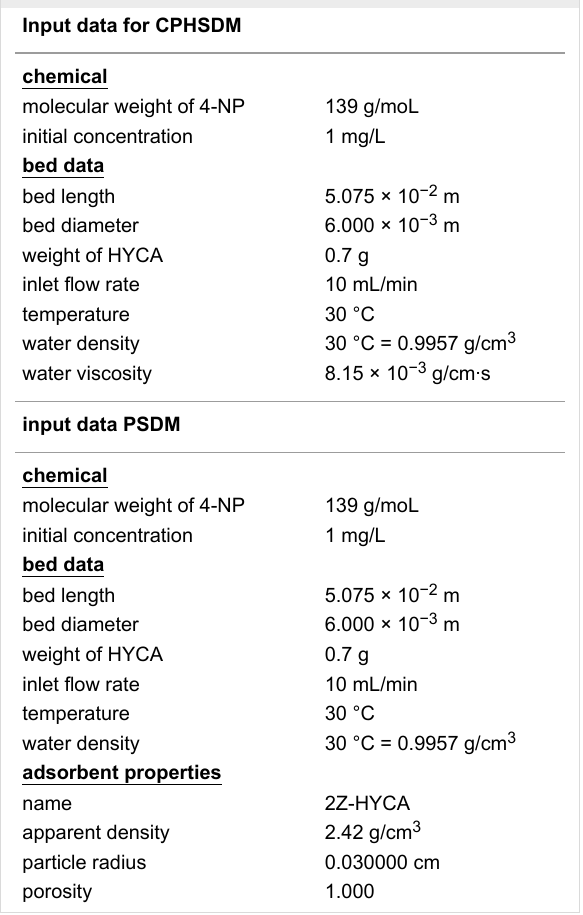
Table 1: Input data for pore and surface diffusion model (PSDM) and constant pattern homogeneous surface diffusion model (CPHSDM) modelling using AdDesignS